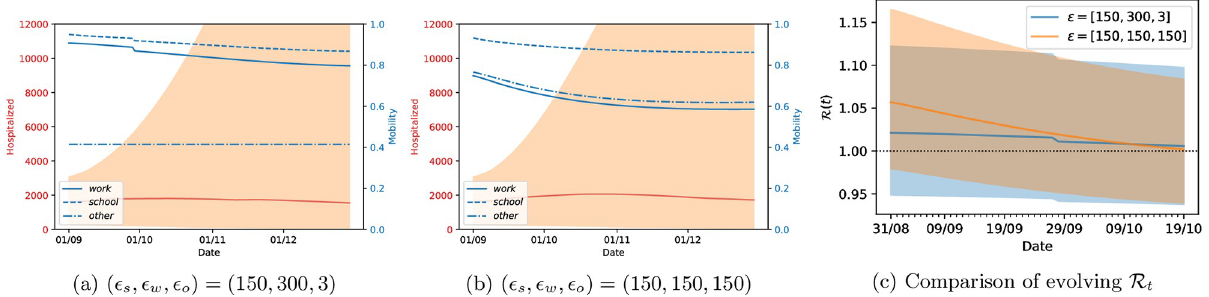
Fig 13. Optimal strategy for England with parameters fitted with data up to the 31st August. The lockdown strategy is applied for 120 days starting on the 1st of September and uses a prediction horizon of T opt = 30 days.